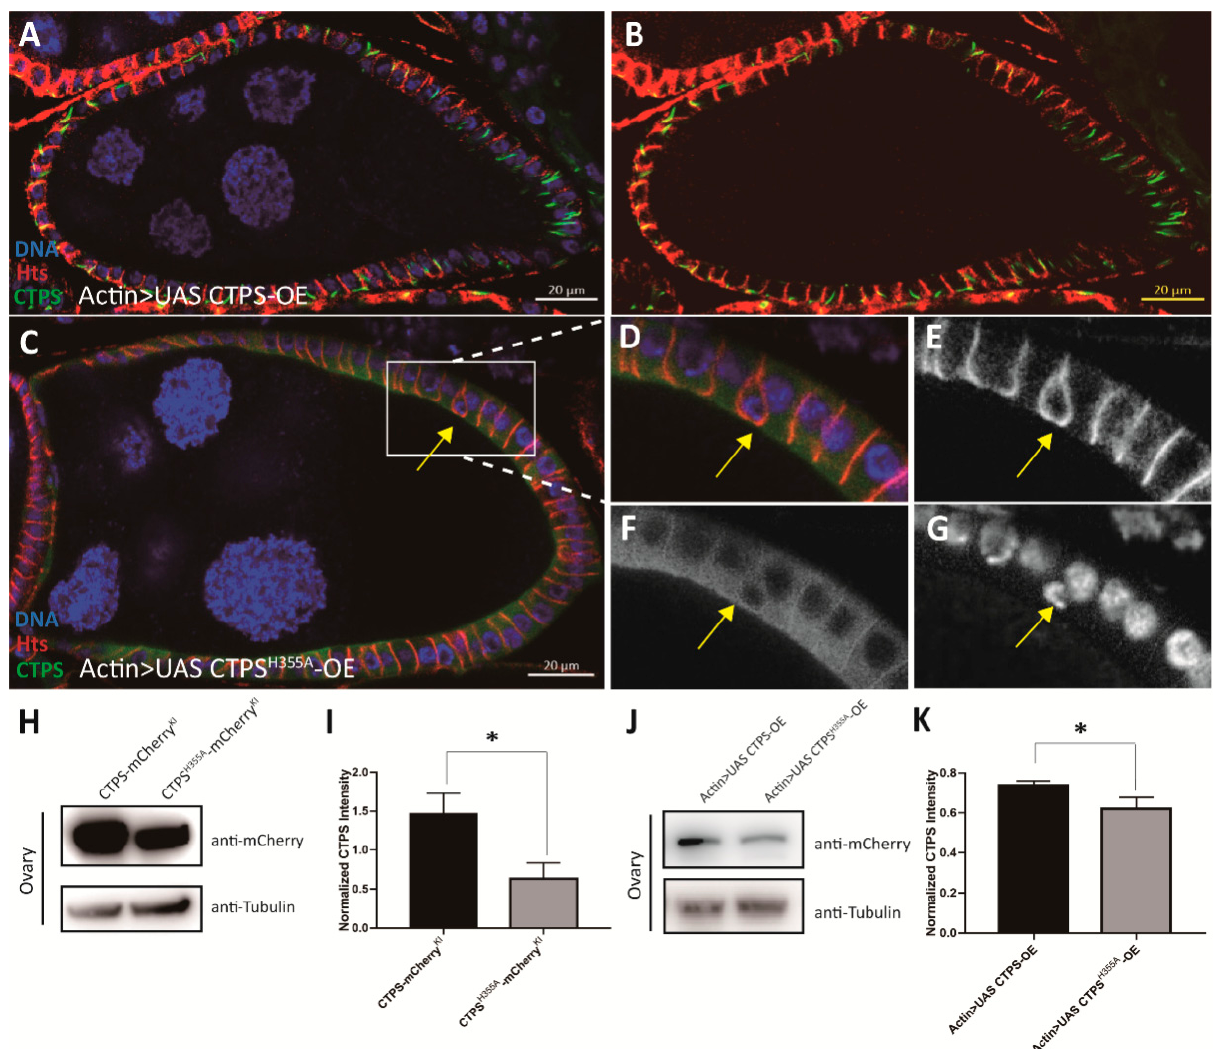
Figure 9. Follicle cell ingression occurs in egg chamber overexpressing CTPS H355A . ( A , B ) Side view of stage 8 egg chamber overexpressing CTPS . ( C ) Cross section of stage 8 egg chamber overexpress- ing CTPS H355A . The ingression is framed by a rectangle. ( D – G ) Zoom-in images of the ingression follicle cells in ( C ). Scale bars, 20. ( H ) Western blot is detected with antibodies against mCherry and tubulin on the ovarian lysates of CTPS-mCh and CTPS H355A -mCh mutants. Scale bars, 20 μ m. ( I ) Quantitative analysis of the CTPS protein level of samples represented in ( H ), the mean and stand- ard deviation. ( J ) Western blot of the ovarian lysates of Actin > UAS CTPS-OE and Actin > UAS CTPS H355A -OE mutants, detected with antibodies against mCherry and tubulin. ( K ) Quantitative analysis of the CTPS protein level of samples represented in ( J ), the mean and standard deviation. ns, non-significant; *, p < 0.05; Mann-Whitney U test.